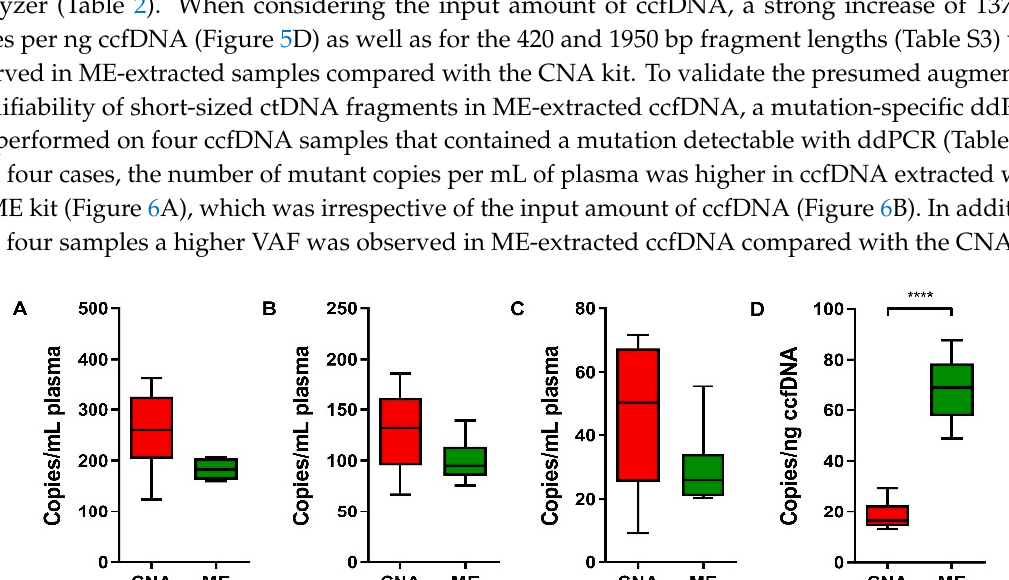
Figure 6. Mutation detection among the CNA and ME extraction methods in DLA samples. ( A ) Before-after plot illustrating the number of mutant copies per mL of plasma for four paired CNA- extracted (dots) and ME-extracted (squares) samples. ( B ) XY plot illustrating the detected mutant copies per mL of plasma plotted against the input in ng on the x-axis. Similarly colored results originate from the same patient harboring a detectable mutation according to the legend. ( C ) Bar graph illustrating the detected VAF in a percentage of four paired CNA-extracted (red) and ME- extracted (green) samples. 3. Discussion In this study, the CNA kit served as the golden standard approach to evaluate the extraction of ccfDNA of other extraction methods regarding yield or integrity using plasmas of cancer patients, which eventually could lead to a higher sensitivity of variant detection. Based on our twenty-one plasma samples derived from cancer patients, both the integrity and levels of amplified short-sized fragments and tumor-specific mutants relative to the input amount of ccfDNA (in ng), as calculated for each reaction individually, revealed no differences between the RSC and CNA kits. However, when using the ccfDNA yield determined with DNA quantification methods such as Qubit or quantitative PCR approaches as reported in most other studies, the yield of ccfDNA, as well as the yield of short-sized fragments, is significantly higher using the CNA kit in cancer patient-derived plasmas. The ME kit seems a suitable methodology when extraction from high amounts of plasma is favored since, despite a lower yield per mL of plasma, higher mutant copy numbers and VAFs were observed. Since the use of different extraction methods might introduce bias to the mutation detection rate, we highly recommend applying the same ccfDNA extraction method within studies, especially when monitoring the treatment response based on multiple plasma samples, to prevent variation in mutant levels due to technical factors. This is further supported by our previous data on spiked-in samples [7].